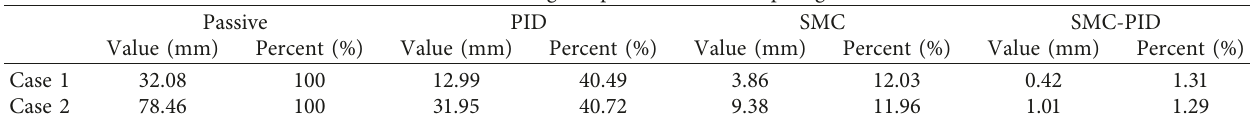
Table 3: The average displacement of the sprung mass.